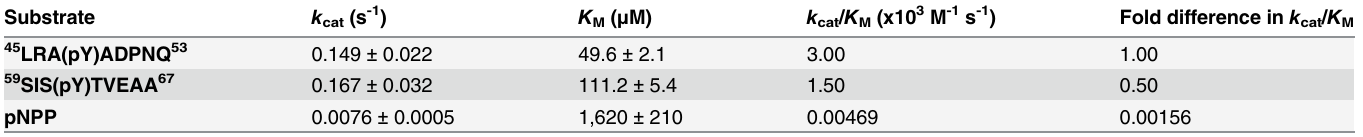
Table 2. Kinetic constants for the hydrolysis of two periplasmic TpbB peptide substrates by TpbA.